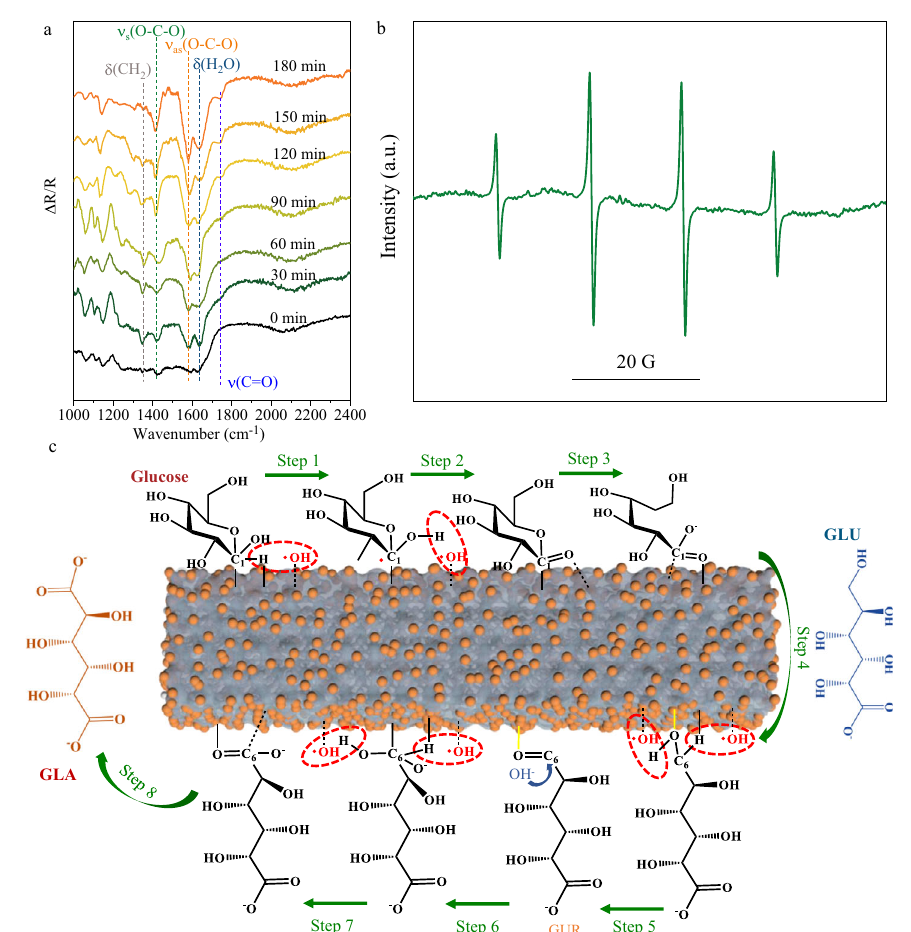
Fig. 6 | Possible reaction pathway from glucose to GLA. a In-situ Fourier trans- forminfraredspectraforPECglucoseconversiononthePt/def-TiO 2 photoanodein 1M KOH with 10mM glucose. b EPR detection of (cid:129) OH using DMPO as a spin-